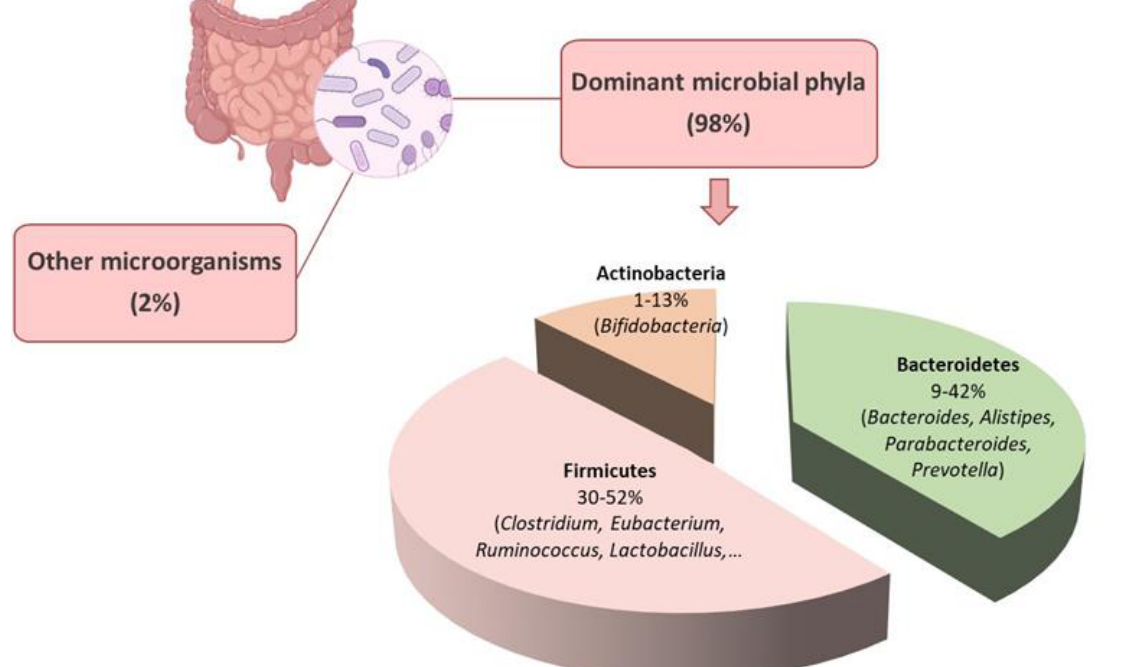
Figure 1. Phylum composition of gut microbiota. The dominant bacteria phyla in the gastrointestinal tract are Bacteroidetes, Firmicutes, and Actinobacteria, which account for about 98% of the total population. More than 90% of the microbial phyla are Bacteroidetes and Firmicutes. Created with BioRender.com.